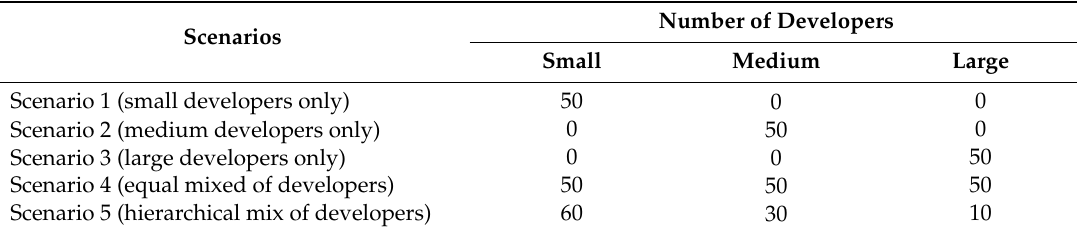
Table 3. The number of developers under each development